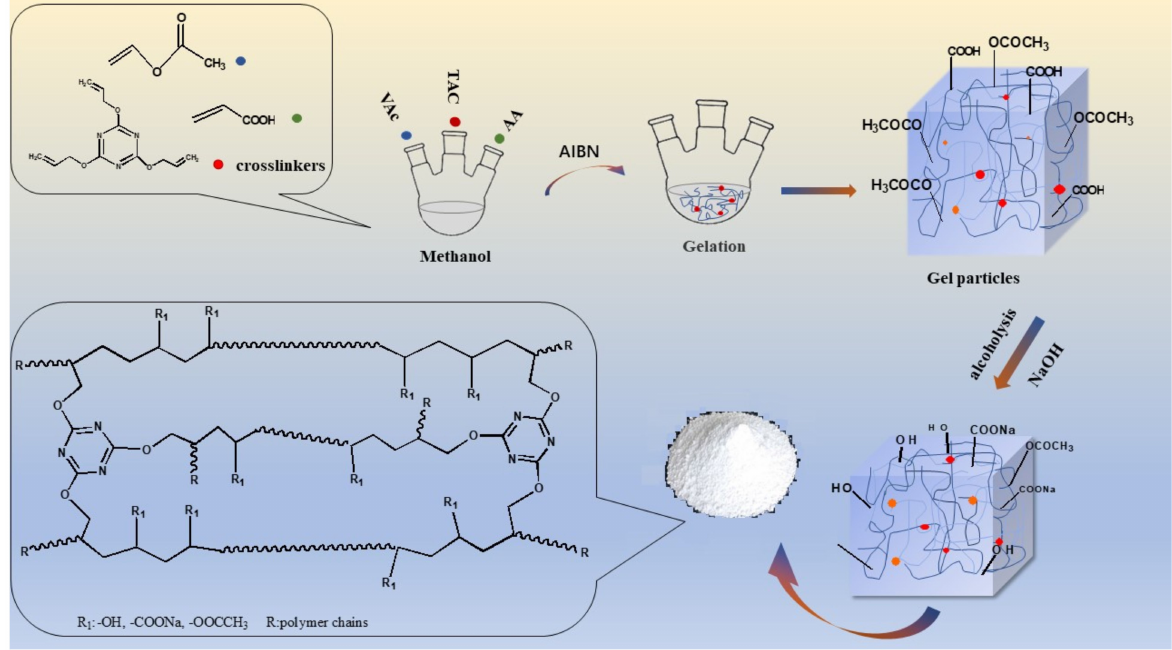
Figure 1. Flowchart of the reaction and alcoholysis of